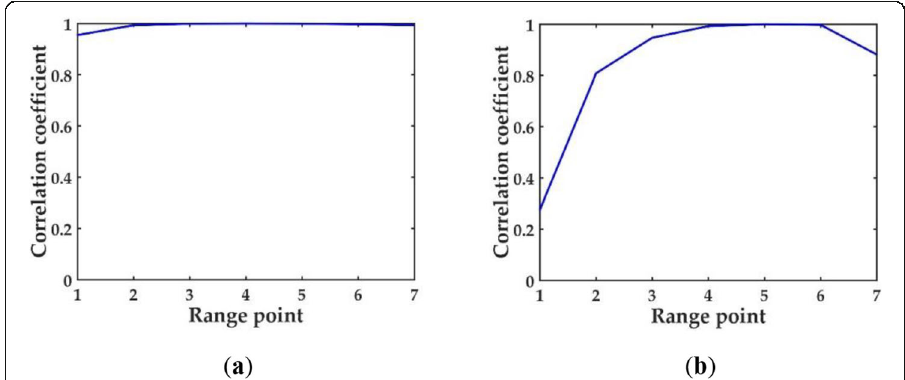
m ∈ [ p − w h , p + w h ] between human and dog targets. a Human target. b Dog